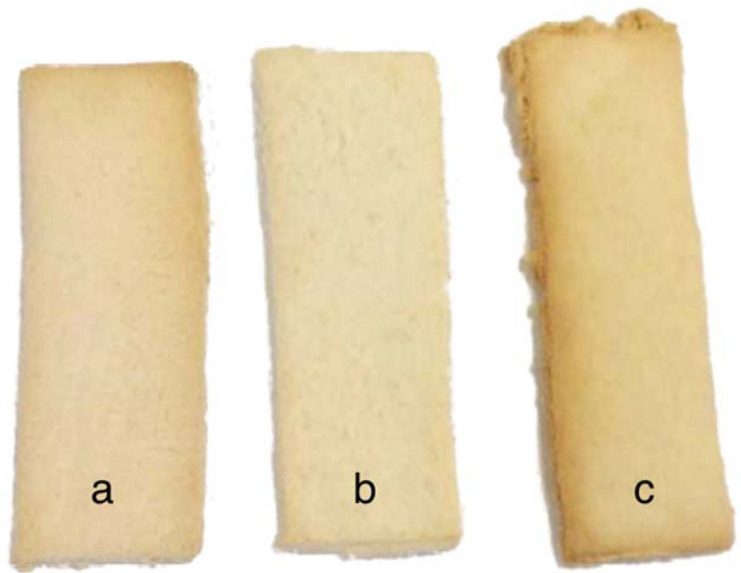
Figure 2. Experimental samples 4 ( a ) and 6 ( b ) and reference biscuit (RIB) ( c ).